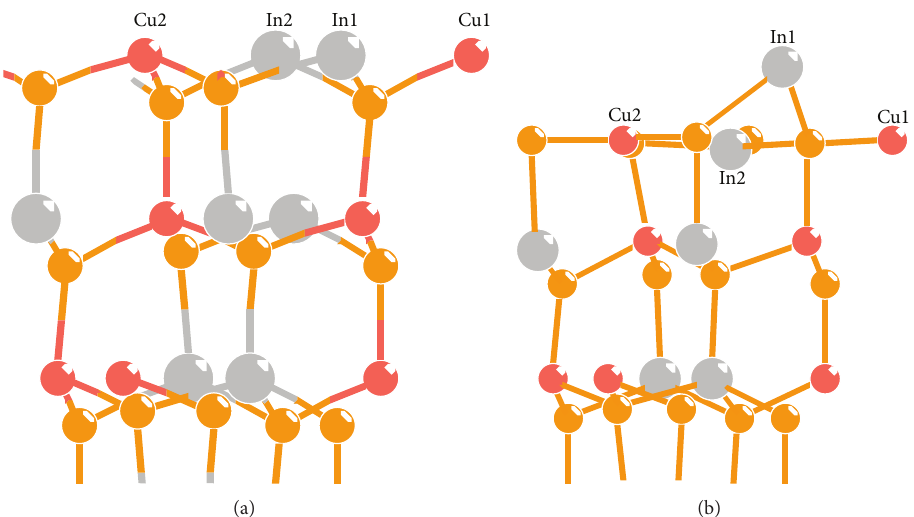
Figure 1: Atomic structure of the (112) surface: (a) the surface before atomic relaxation and (b) the surface after atomic relaxation. The red, gray, and yellow balls represent Cu, In, and Se atoms, respectively.